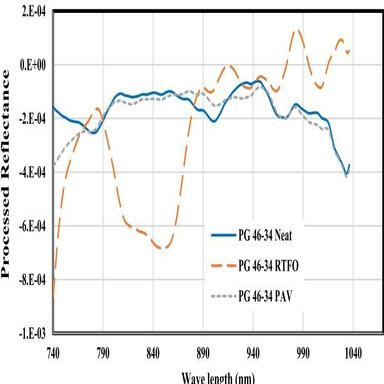
Comparison of the PG 46-34 binders with different aging levels.